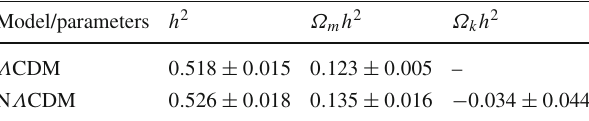
Table 4 The mean and uncertainty of parameters in Λ CDM and N Λ CDM using the GLM